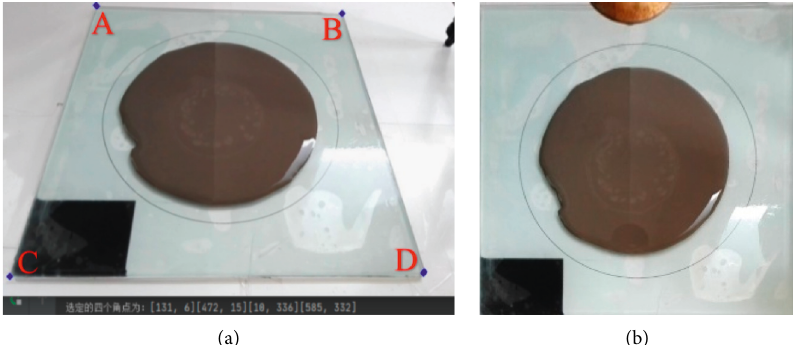
Figure 1: Correction results of manual point selection method: (a) original image; (b) corrected image.